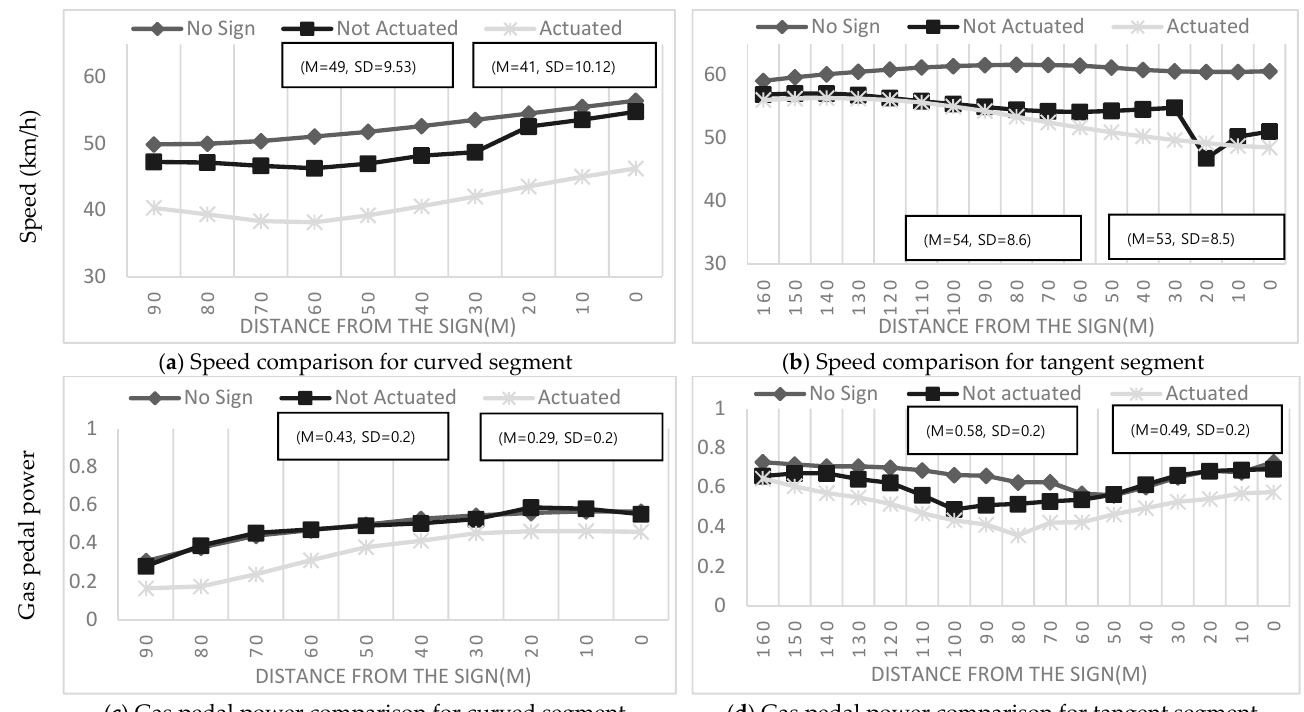
( d ) Gas pedal power comparison for tangent segment Figure 7. Speed and gas pedal power comparison between no-sign conditions and each sign, includ- ing conventional static warning sign and new warning signs for black ice actuated and not actuated by weather.